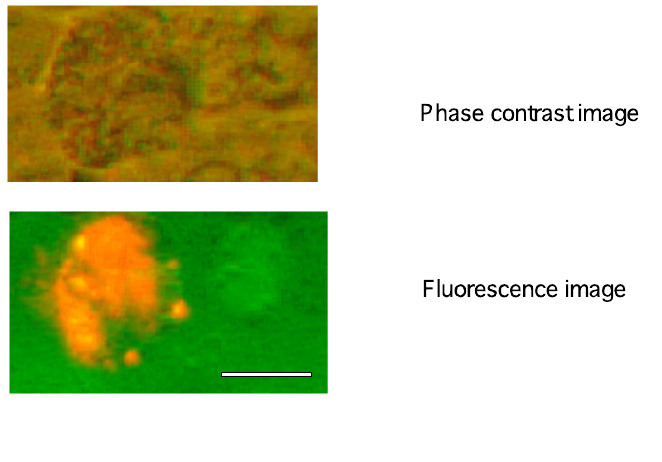
Figure 4. Qdot-GRP78 antibody detected in the tumor samples. The red fluorescence of Qdot-GRP78 antibody was detected in some of the cells inside tumor. Scale bar represents 20 µ